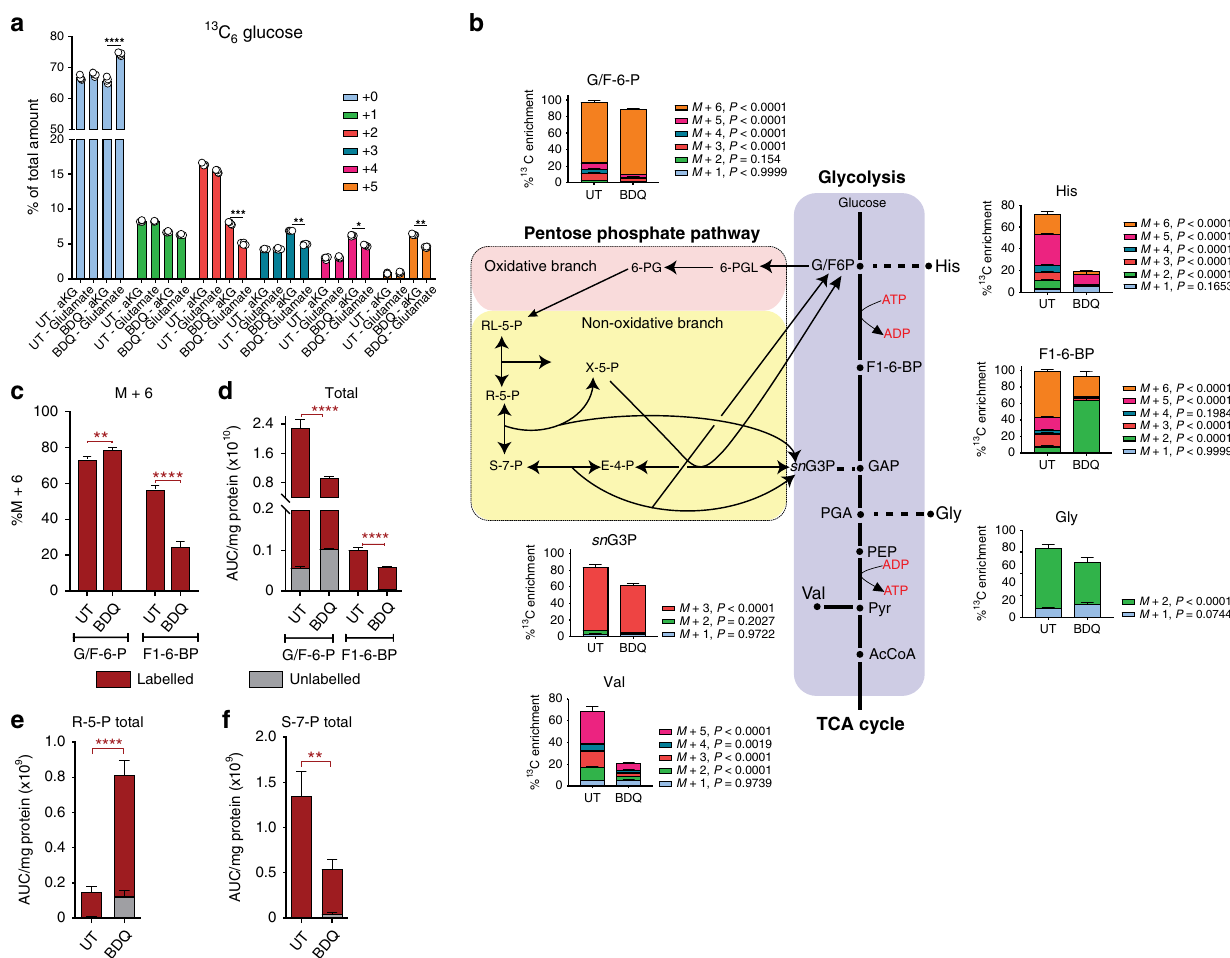
Fig. 1 BDQ modulates glycolysis and the PPP. a The percent total abundance of each labelled and unlabelled isotopologue for glutamate and α - ketoglutarate (aKG) from 13 C 6 glucose as the 13 C tracer. b The percent 13 C enrichment and carbon isotopologue distribution (CID) of glycolytic intermediates and glycolytic intermediate-derived amino acids from 13 C 6 glucose as the 13 C tracer. c The %M + 6 species and ( d ) total glucose/fructose- 6-phosphate and fructose-1,6-bisphosphate. Total levels of ( e ) ribose-5-phosphate (R-5-P) and ( f ) sedoheptulose-7-phosphate (S-7-P) were measured to determine the effects on the PPP. Each column represents the mean + / − standard error of the mean (SEM) of at least three replicates. One representative experiment is shown, with the experiment being repeated a minimum of two times. A two-way ANOVA and a Tukey multiple-comparison test were used for the statistical analysis. G/F-6-P glucose/fructose-6-phosphate, His - histidine, F1,6-BP - fructose-1,6-bisphosphate, snG3P - glyceraldehyde-3- phosphate, Gly - glycine, Val - valine, UT - untreated, BDQ - bedaquiline. n = 4 biologically independent samples. * P < 0.05, ** P < 0.01, **** P <